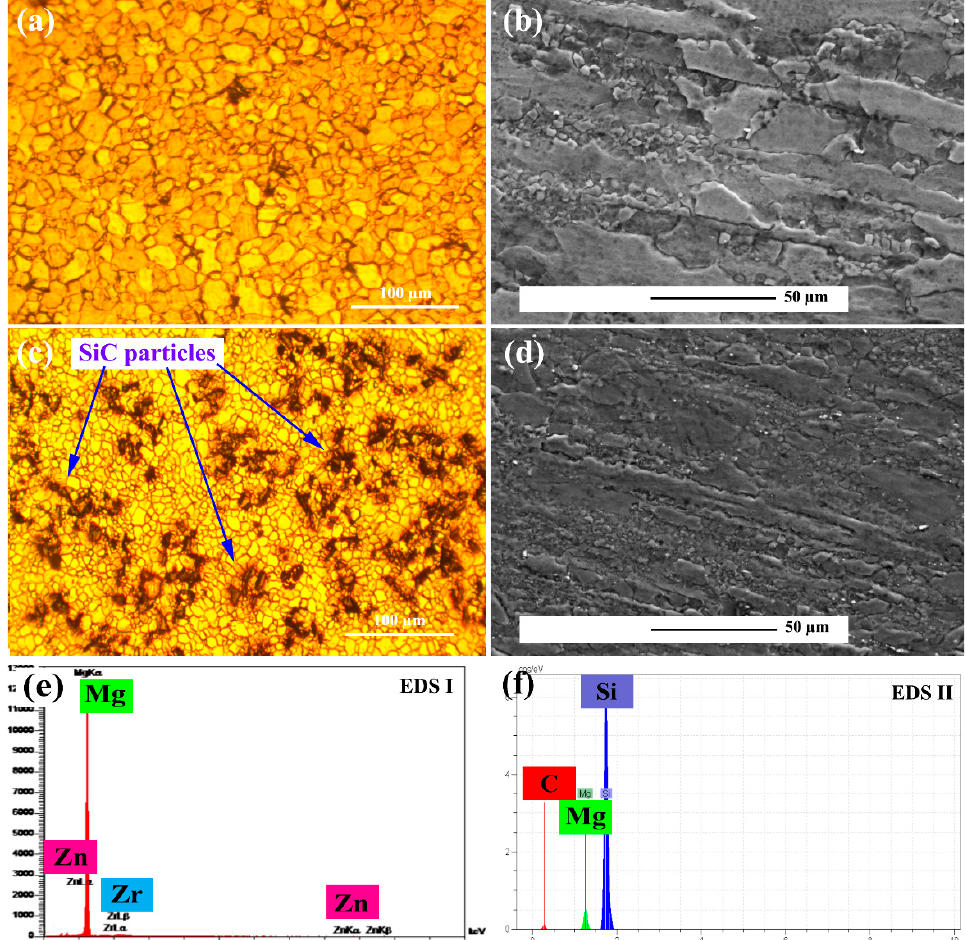
Figure 2. Microscopic image after extrusion: ( a ) unreinforced alloy perpendicular to the extrusion direction, ( b ) unreinforced alloy in the directional of extrusion, and ( c ) ZK60/SiC p composite perpendicular to the extrusion direction, ( d ) ZK60/SiC p composite in the directional of extrusion, ( e ) EDS analysis of the matrix of the ZK60/SiC p composite, and ( f ) EDS analysis of the matrix of the ZK60/SiC p composite.